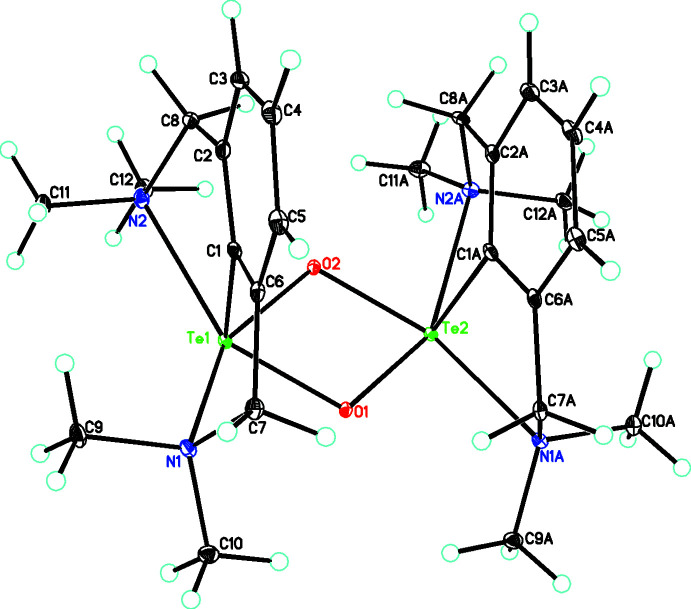
The mol­ecular structure of the [C24H38N4O2Te2]2+ cation, showing the cis arrangement of the phenyl rings with respect to the Te2O2 core. Atomic displacement parameters are drawn at the 30% probability level.